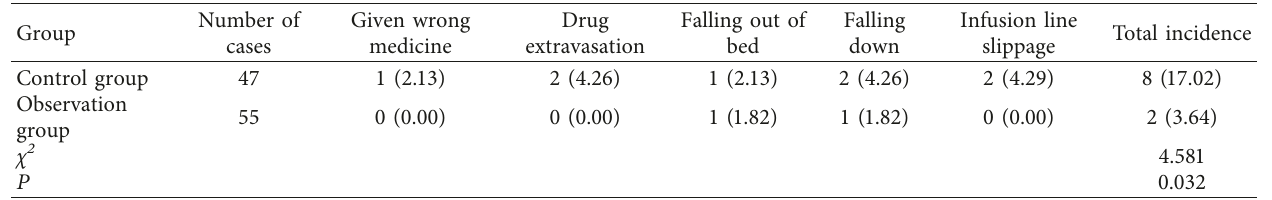
Table 3: Occurrence of adverse events in the two groups of patients ( n , %).